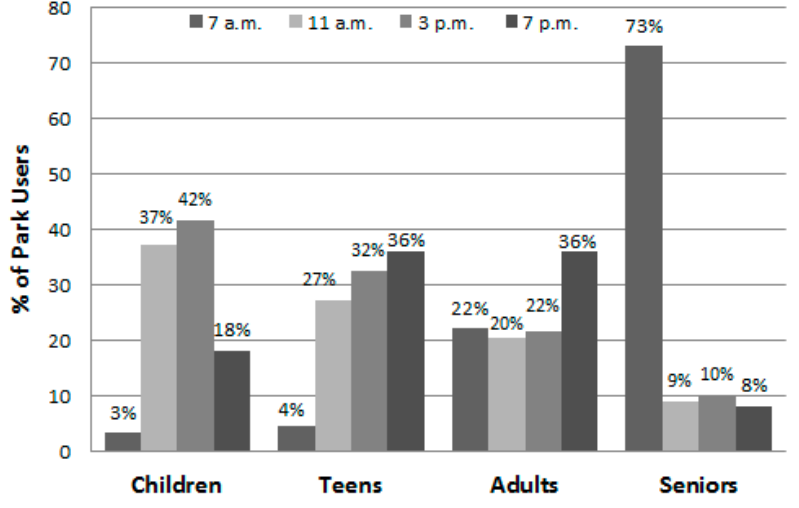
Figure 5. Percent of park users by age group and time of day ( n = 28,585).